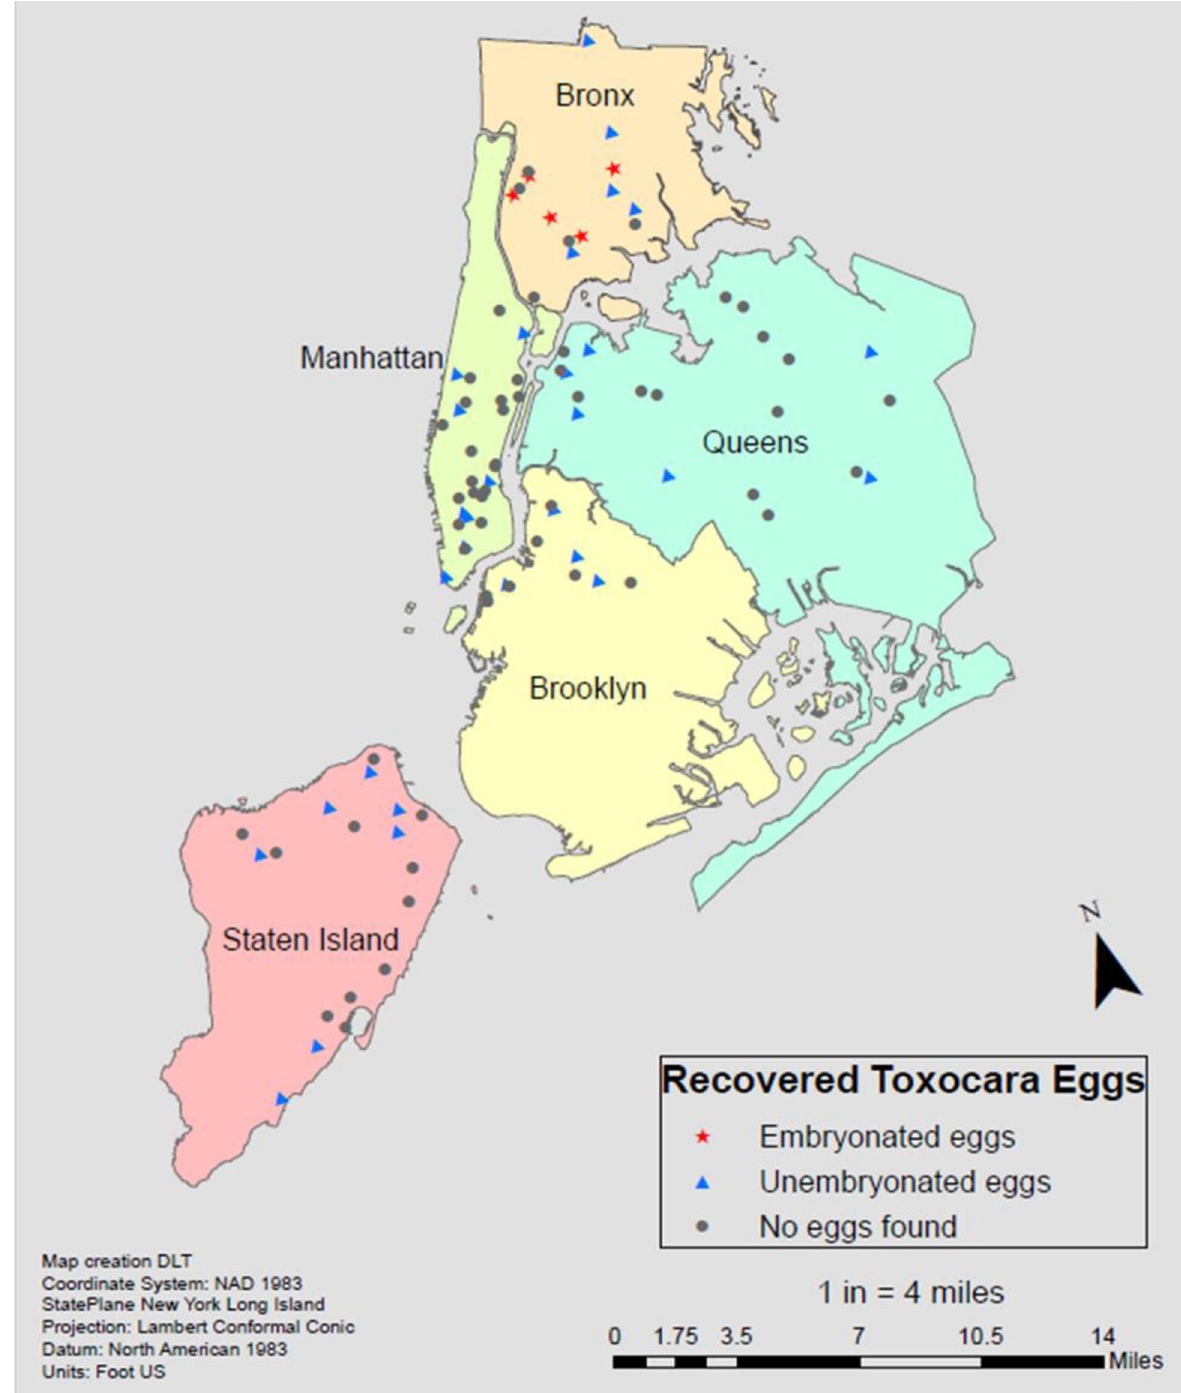
Fig 2. Geospatial results of Toxocara sampling across NYC. Toxocara was found in those sites represented by either blue triangles (unembryonated egg(s)) red stars (embryonated egg(s)). Toxocara was not found at sites marked by black circles. The highest density of Toxocara geo-contamination was found in the Bronx, which was the only borough where infected larvae were found. Sampling ArcMap of NYC, created using ArcGIS 10.6.1.